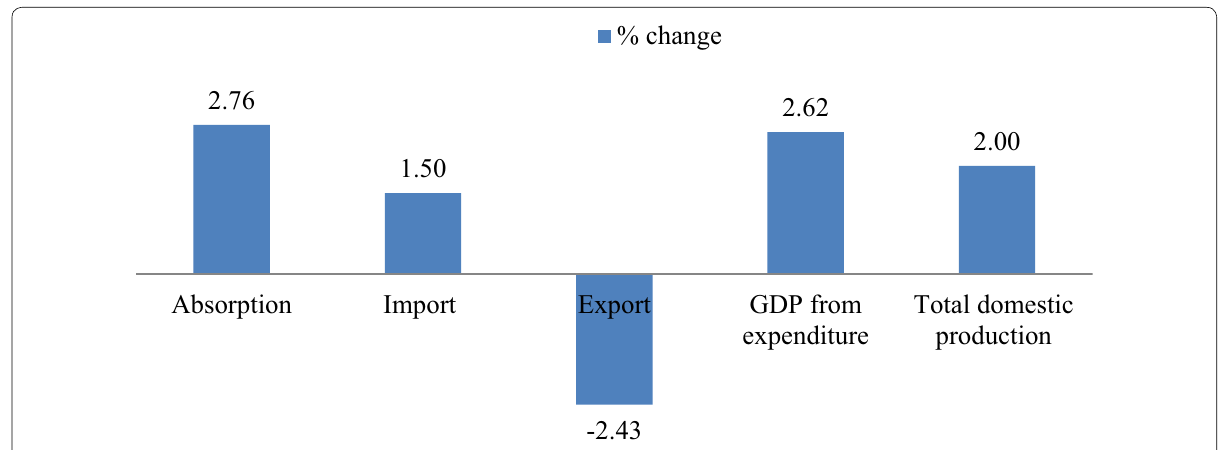
Fig. 4 Macroeconomic impact (percentage changes) Source: Author’s computation based on model